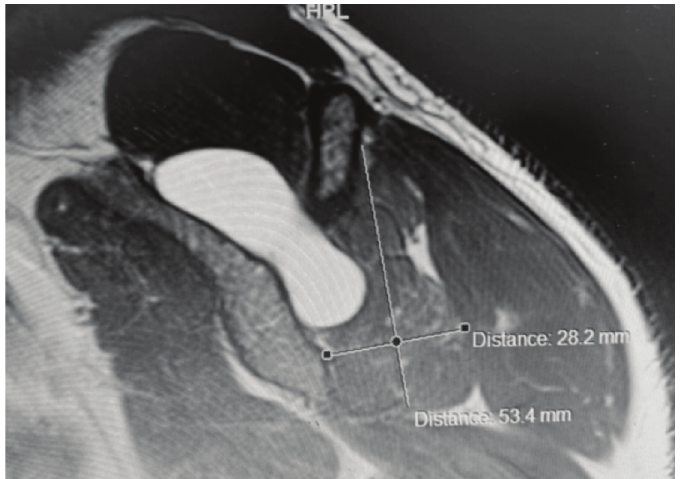
T2 weighted image showing a spinoglenoid cyst over the supraspinous fossa of the shoulder. Cruciform measurements show the Fig. 1: presence of infraspinatus muscle atrophy.